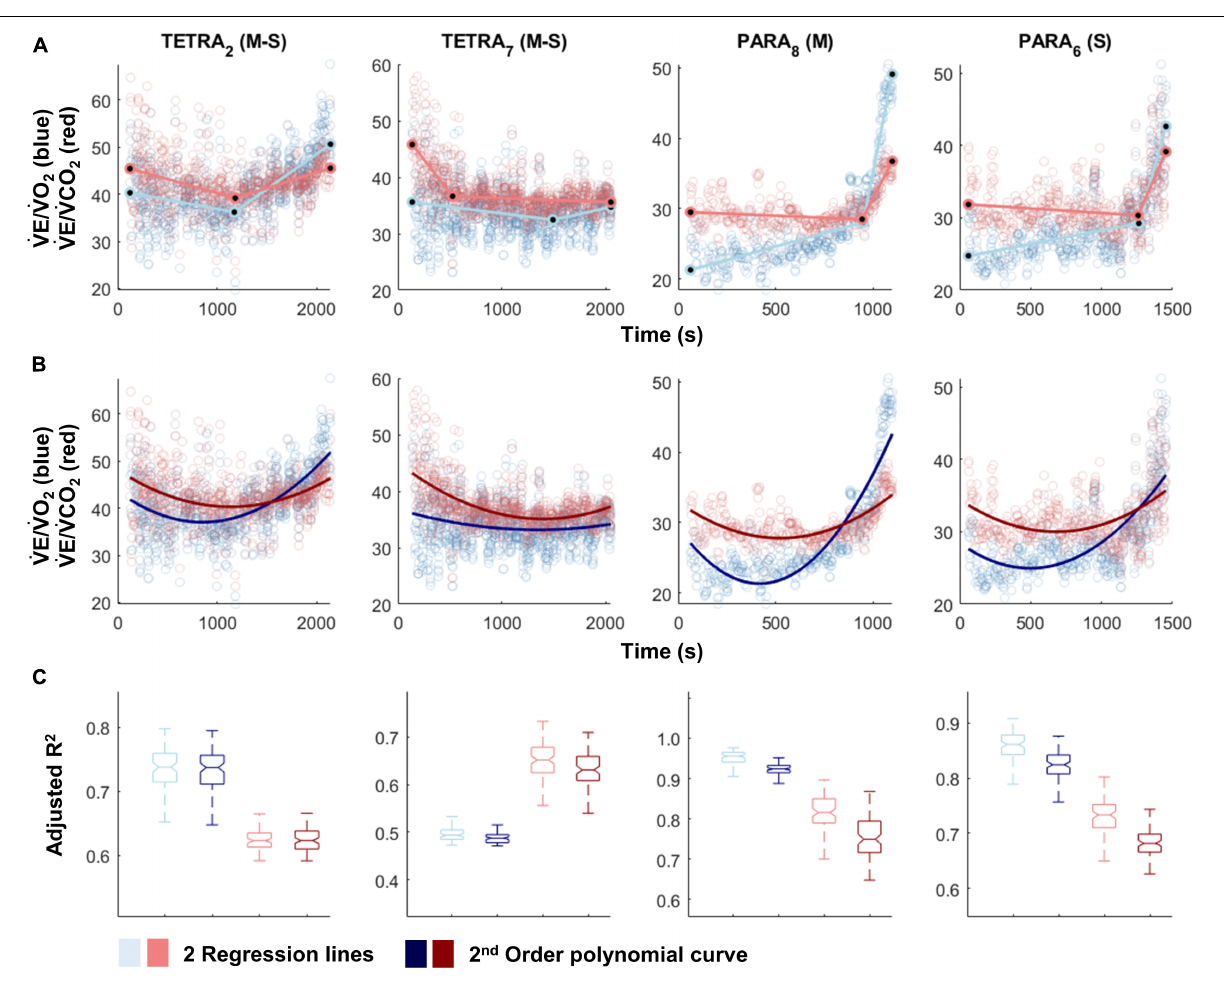
FIGURE 3 | ˙VE/˙VO 2 -time (blue) and ˙VE/˙VCO 2 -time (red) plots fitted with the two linear regression lines (breakpoint model, ventilatory equivalent method; A ) and a second order polynomial (no-breakpoint model; B ) for two example athletes with tetraplegia and paraplegia (TETRA 2 , TETRA 7 ; PARA 8 , PARA 6 ; participant number in subscript). Notched boxplots are presented to compare the adjusted R 2 values between the breakpoint and the no-breakpoint model for each participant (C) . Figures for all individual participants are provided in Supplementary Figure 4 . ˙VO 2 , Oxygen uptake; ˙VCO 2 , carbon dioxide production; TETRA, wheelchair athlete with tetraplegia; PARA, wheelchair athlete with paraplegia, M, motor complete injury; S, sensory complete